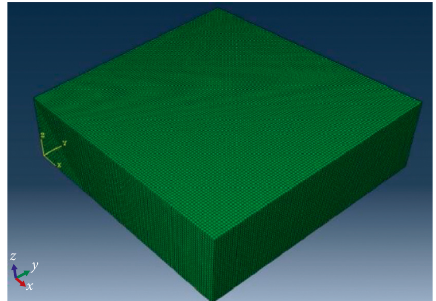
Figure 5: Initial three-dimensional numerical